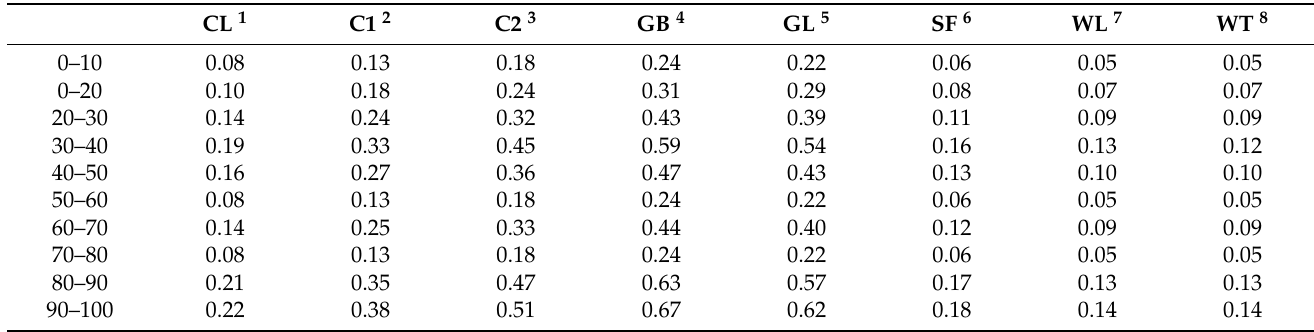
Table 3. Class and area group-wise classification accuracy for MODIS